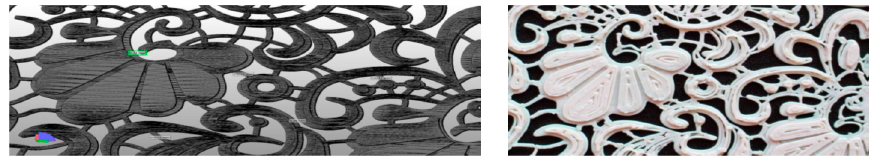
Figure 15. Multi-layer lace pattern, depicted in “netfabb” (left panel), and the resulting 3D print (right panel) [55] .